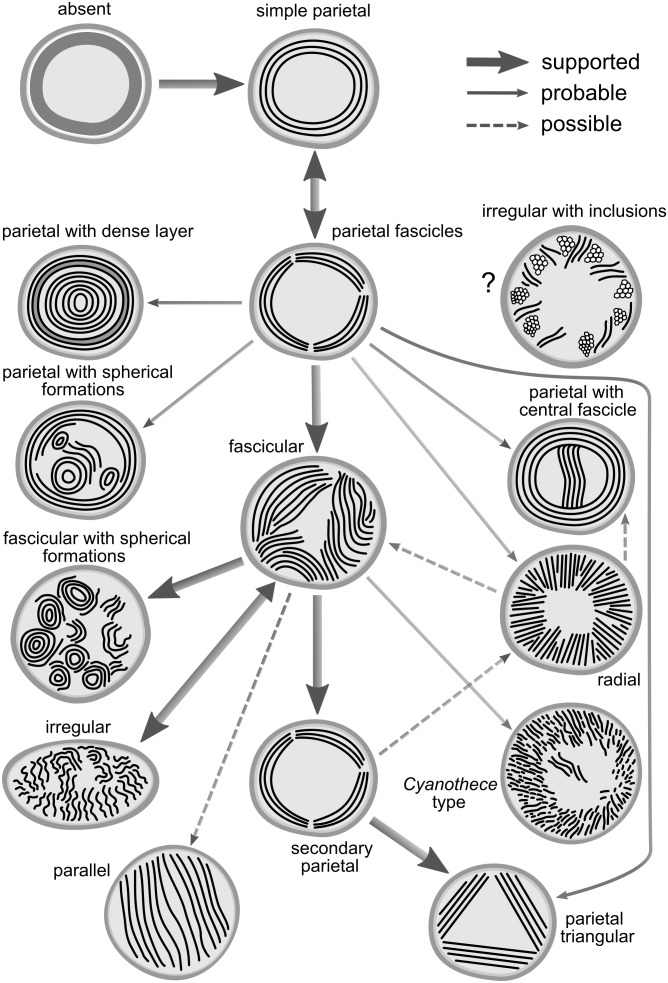
Hypothetical concept of evolutionary routes connecting the known thylakoid architectures. Thick solid lines indicate relationships supported in both the SSU rRNA and the multilocus tree. Fine solid lines indicate probable relationships inferred from one of the trees but missing (due to taxon sampling) or equivocal in the second tree. Dashed lines indicate possible relationships with low support or contradictory between the two trees.